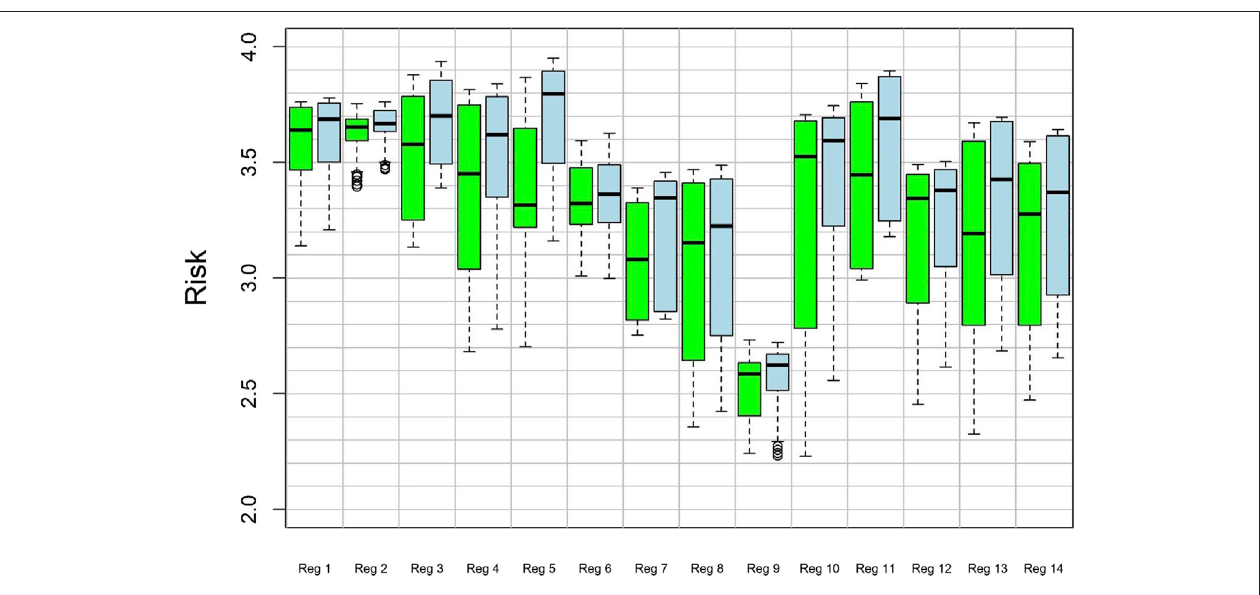
FIGURE 8 | Box plot of risk scores (RS) derived for the summer for each of the 14 subregions. Green box plot isfor the RCP4.5 emissions scenario, and blue is for theRCP8.5emissionsscenario.Thelistofregionsisasfollows:1)WestCoast,2)Southwest,3)DeepSouth,4)Mid-Atlantic,5)South-CentralUS,6)Florida,7)Hawaii,8) Rockies, 9) Alaska, 10) Midwest, 11) Northeast, 12) West, 13) Central US, and 14) Eastern Canada. The thick black lines of the boxplots indicate the median value while the box shows the range between the fi rst and third quantiles. The points outside the range of the whiskers can be considered as